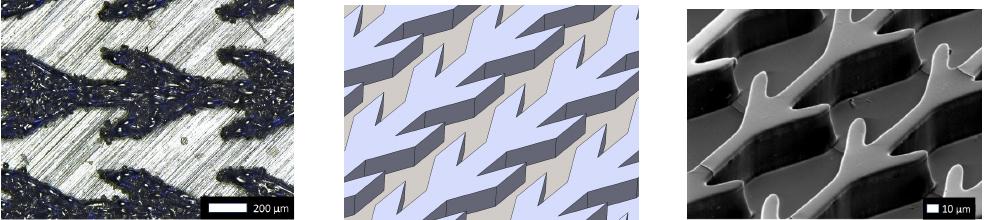
Figure 1. Fin shaped structures added to a flat surface. Top views of the fin-shaped structure studied here and manufactured by Selective Laser Melting (SLM) in a picture from above ( left ), CAD in an isometric view ( middle ), and original Polydimethylsiloxane (PDMS) part ( right ). Notice the different scales and compare the rough metallic structure manufactured by SLM ( left ) with the smooth surface considered in [16] made of resin ( right